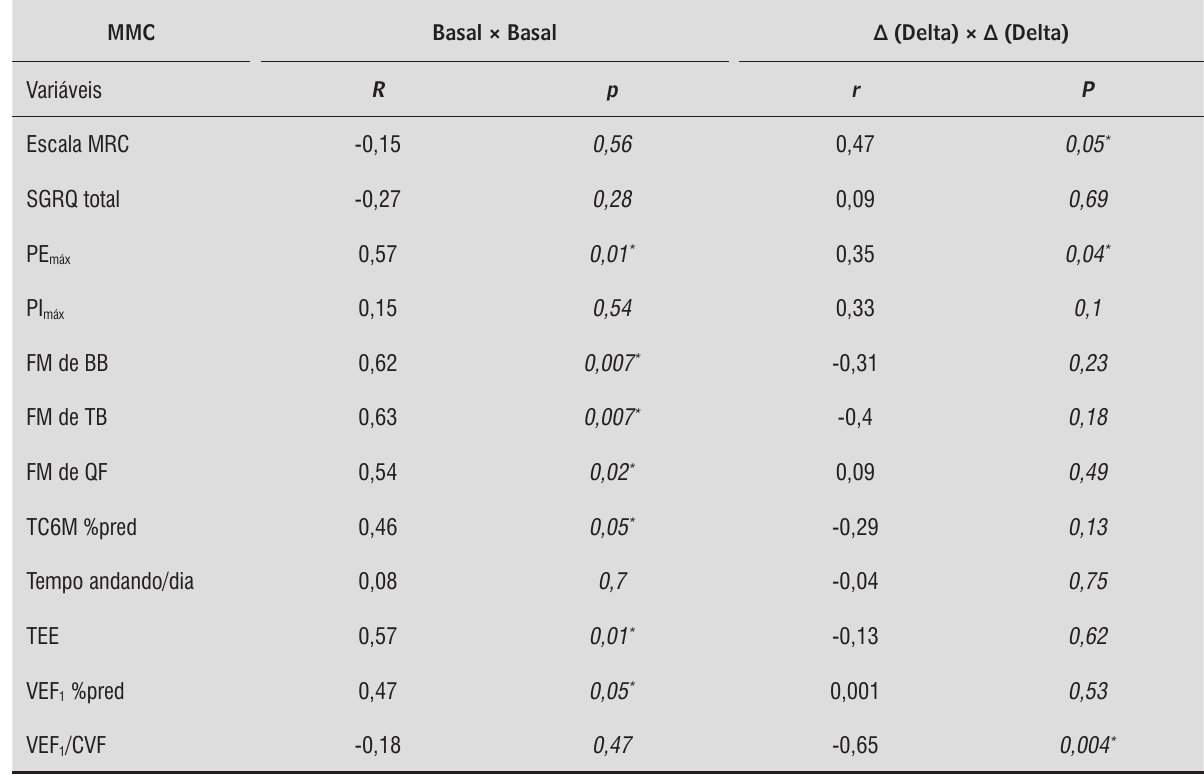
Tabela 2 - Correlação dos valores basais e deltas (melhora após treinamento físico) entre o MMC e as